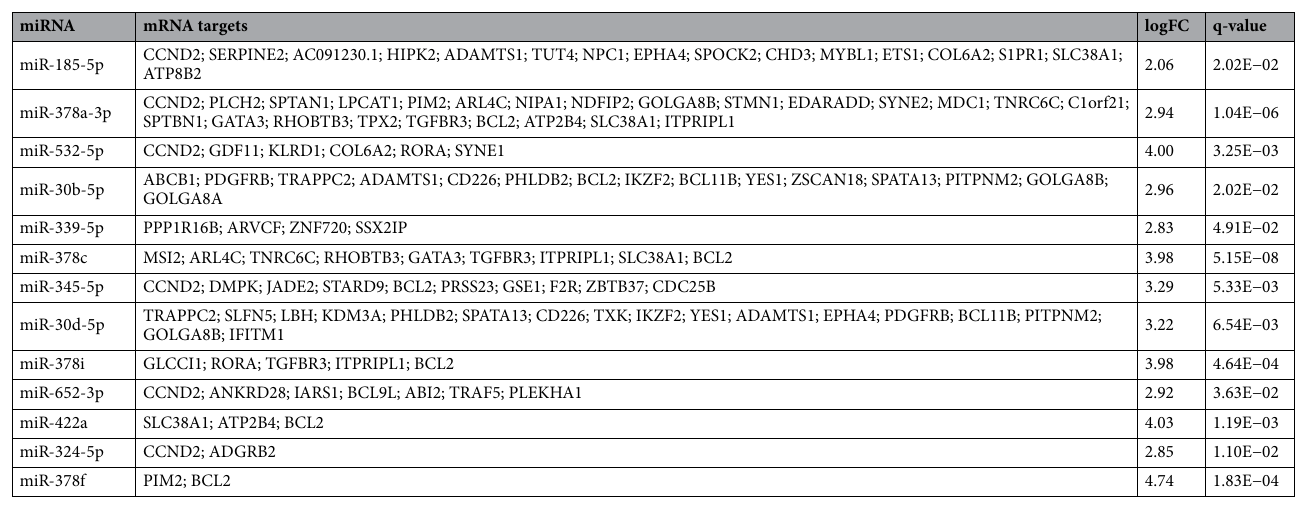
Table 2. Acute myocardial infarction (MI) specific miRNAs (logFC > ± 2) and their validated mRNA targets based on correlation analysis (Pearson’s correlation r ≤ − 0.85). The logarithmic fold change (FC) is given for the differentially expression in nonclassical monocytes between control and MI patients.